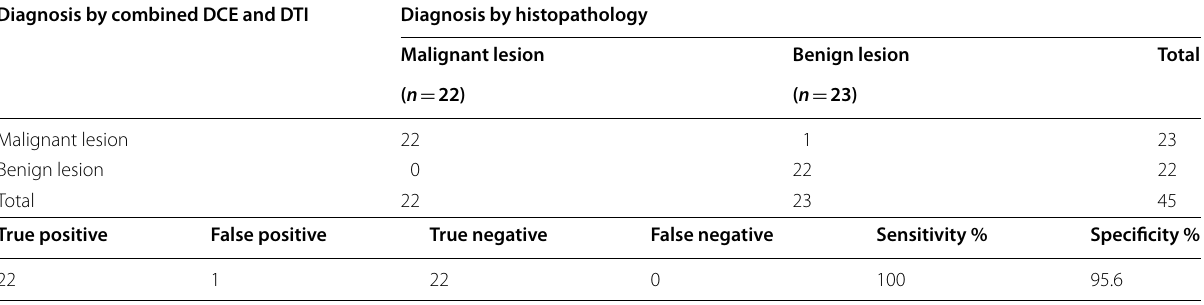
DCE: Dynamic contrast enhancement. DTI: diffusion tensor imaging